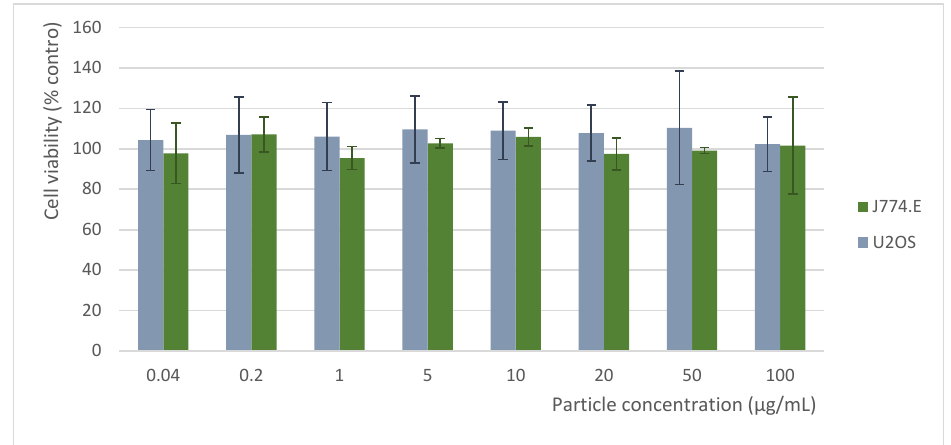
Figure 5. Mean (±SD) viability of J774.E murine macrophages and U2OS human osteosarcoma cells Figure 5. Mean ( ± SD) viability of J774.E murine macrophages and U2OS human osteosarcoma cells exposed for 48 h to different concentrations of GdPO 4 : 15%Mn 2+ , 1%Eu 3+ . Viability determined by exposed for 48 h to di ff erent concentrations of GdPO 4 : 15%Mn 2 + , 1%Eu 3 + . Viability determined by MTT assay and expressed as the percent of control (results obtained from three independent